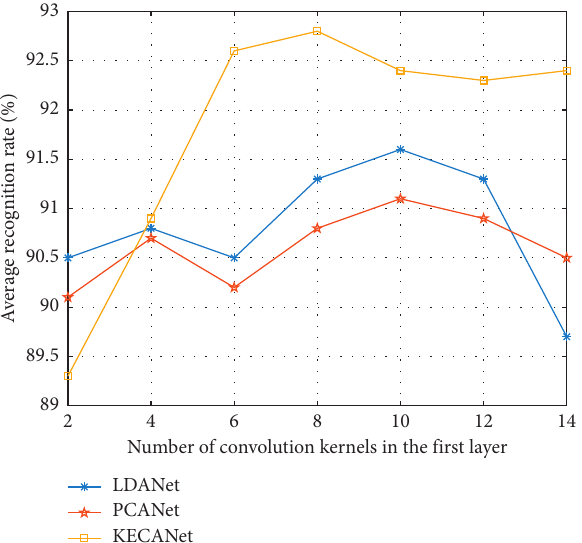
Figure 15: The average recognition rate corresponding to different values of L